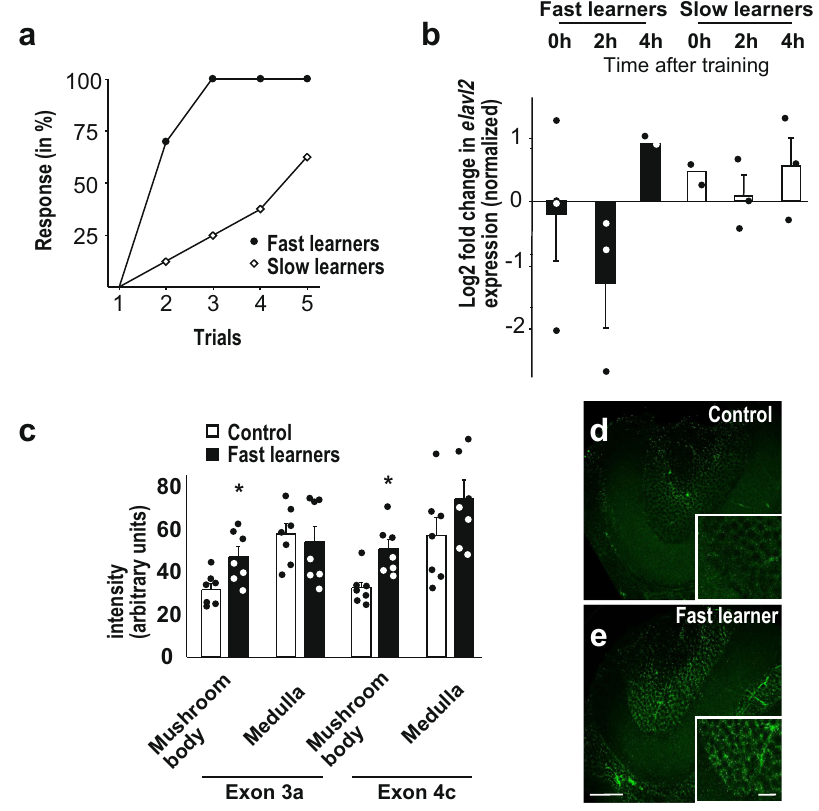
Fig. 6 elavl2 alternative splicing and expression levels change upon learning. a Learning response of bees grouped into fast and slow learners (fast learners n = 10 and slow learners n = 8). b elavl2 mRNA expression levels determined by qPCR 0, 2, and 4 h after training shown as mean with the standard error from two to four independent replicates central brains normalized to Appl expression ( p = 0.13). c Inclusion levels of elavl2 exons 3a and 4c quanti fi ed from RNA in situ hybridizations from control (unpaired) and fast learning (paired) bees in the mushroom body and the medulla ( p < 0.05, n = 7). d , e Representative RNA in situ hybridizations against exon 3c in mushroom bodies of control ( d ) and fast learning ( e ) bees 2 h after training. Scale bars are 30 µ m in E and 6 µ m in the inset. The source data underlying this fi gure are available in Supplementary Data